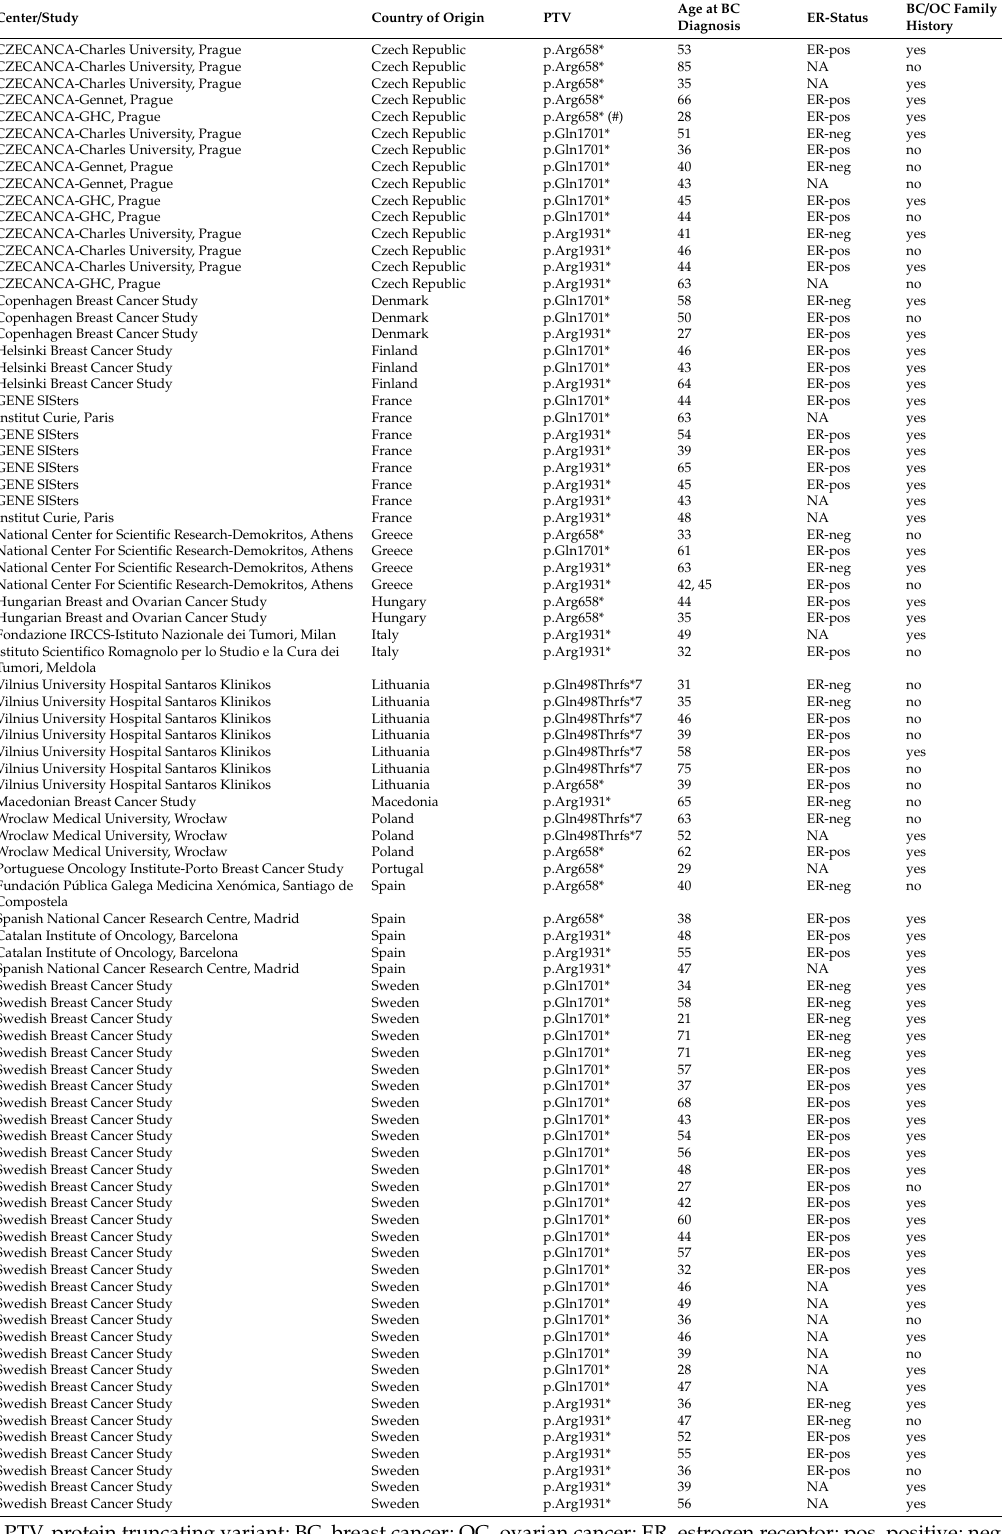
Table 1. Eighty-six breast cancer probands who carry one of the four common FANCM PTVs. Center /